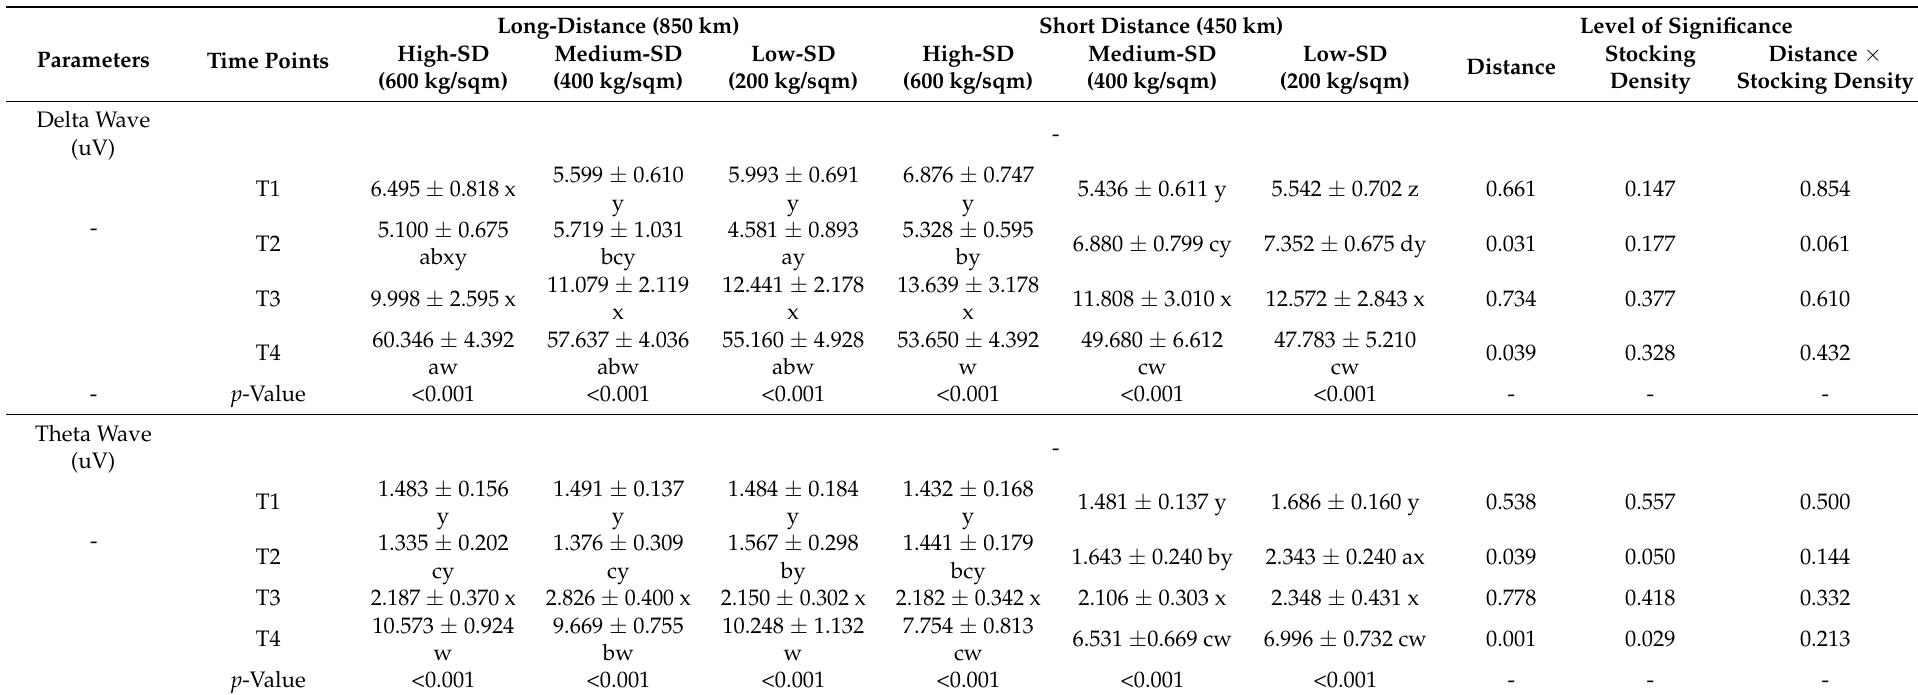
Table 2. Influence of distances and stocking density on the encephalogram of Brahman crossbred cattle (delta and theta. waves) (Mean ± SE).